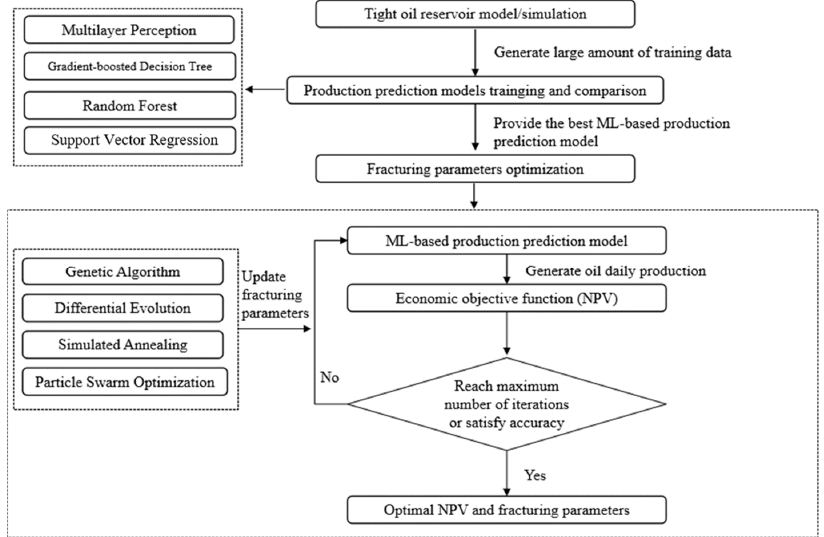
Figure 1. Fracturing parameter optimization workflow.